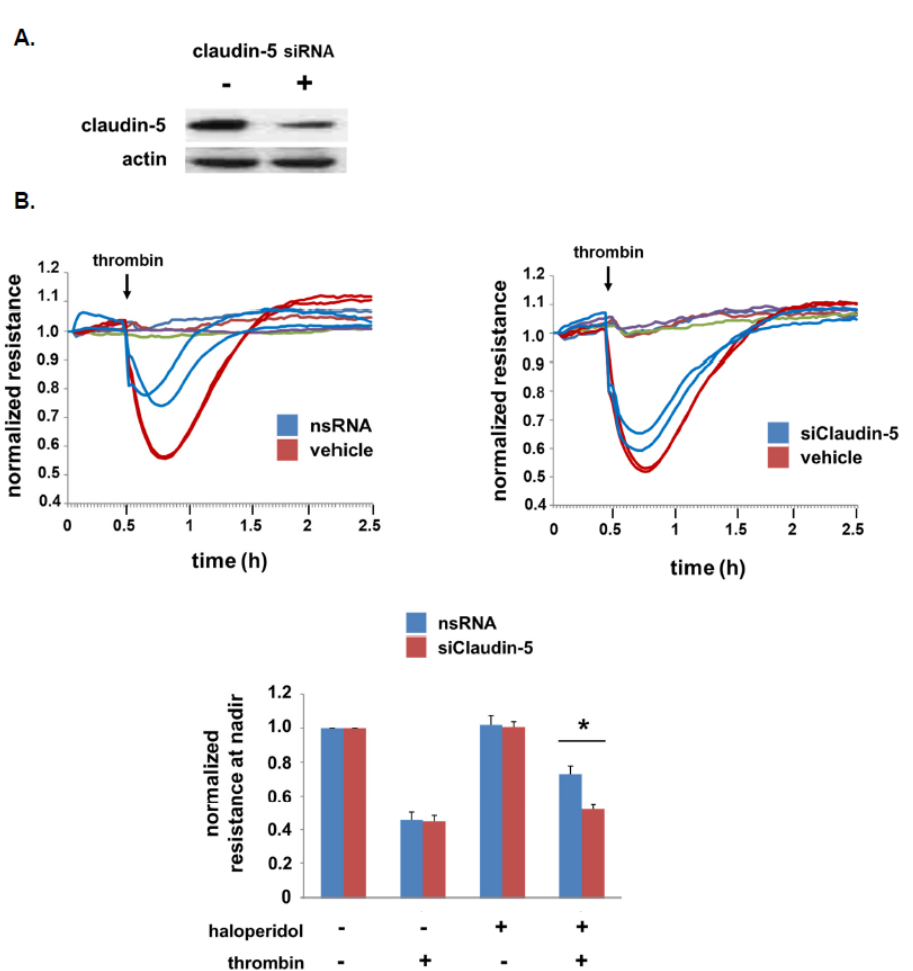
Figure 3. EC barrier protection by haloperidol is mediated by claudin-5. Human pulmonary artery ECs were grown to confluence overlying gold-plated microelectrodes for measurements of transendothelial electrical resistance. Cells were transfected with siRNA specific for claudin-5 (siClaudin-5) or non-specific siRNA (nsRNA) for 3 days with silencing confirmed by Western blotting ( A ). Cells were then treated with haloperidol (10 μ M) for 24 h followed by thrombin stimulation (1 U/mL). Real-time measurements of normalized resistance were recorded and the nadir for each condition was used for the bar graph ( B ) (representative tracings shown; n = 3/condition, * p < 0.05).